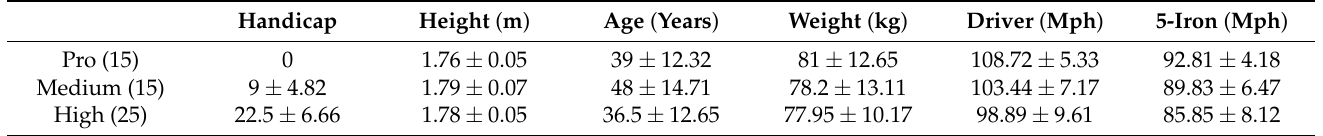
Table 1. Descriptive statistics of the sample (mean and standard deviation) for the three player groups considered: Pro, Medium, and High handicap. Driver (Mph) and 5-iron (Mph) refers to the club speed during the impact expressed in miles per hour.